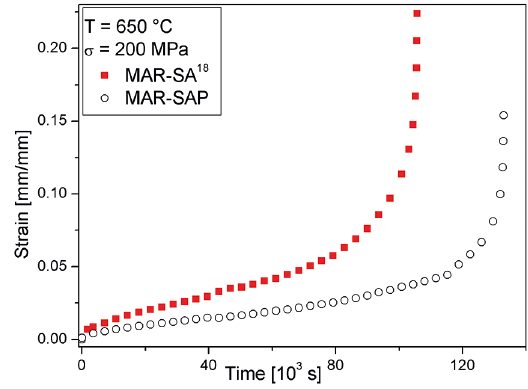
Figure 2: X-ray diffraction pattern of (a) MAR-SA and (b) MAR-SAP.